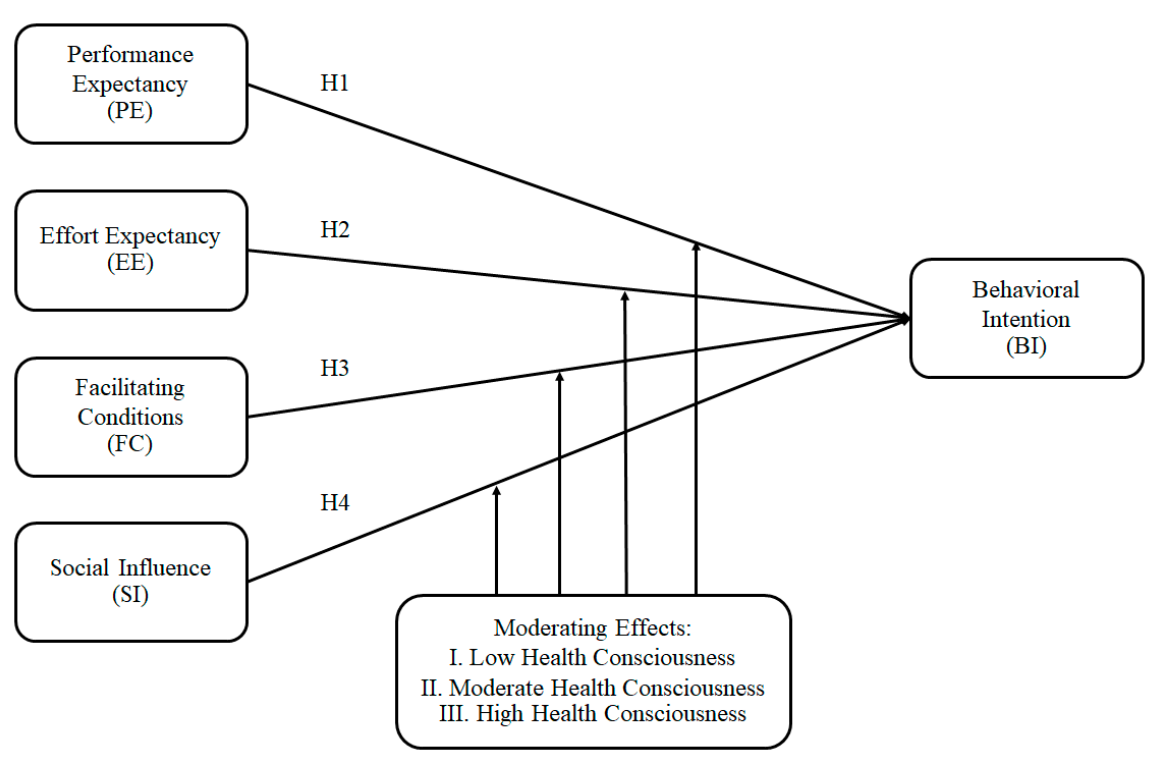
Figure 1. Proposed model. (Source: figure created by authors